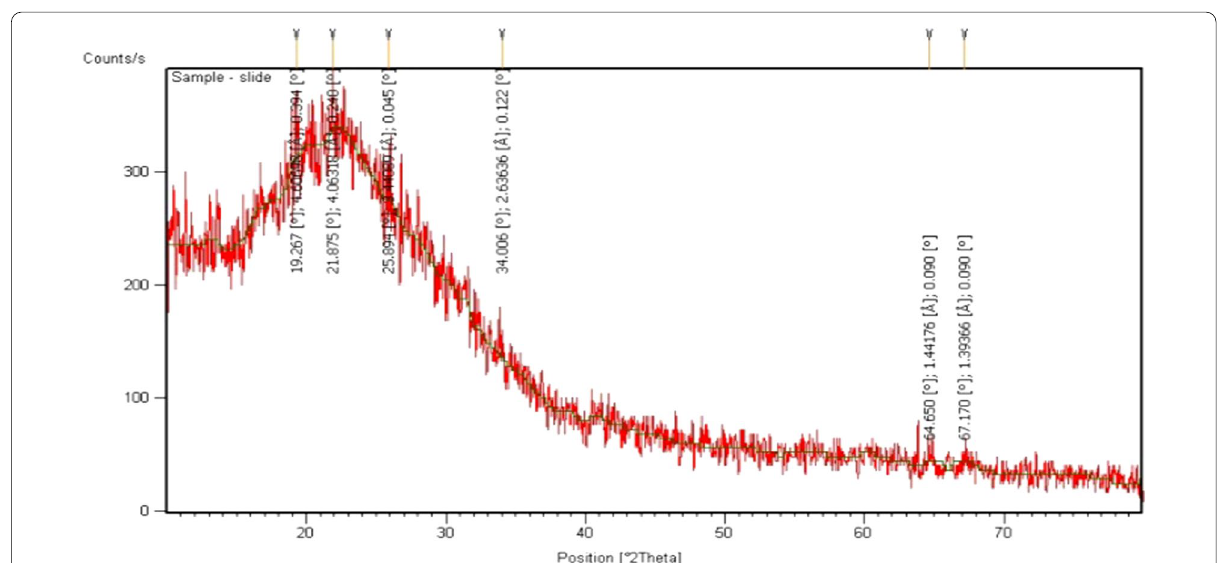
Fig. 3 XRD Spectrum of